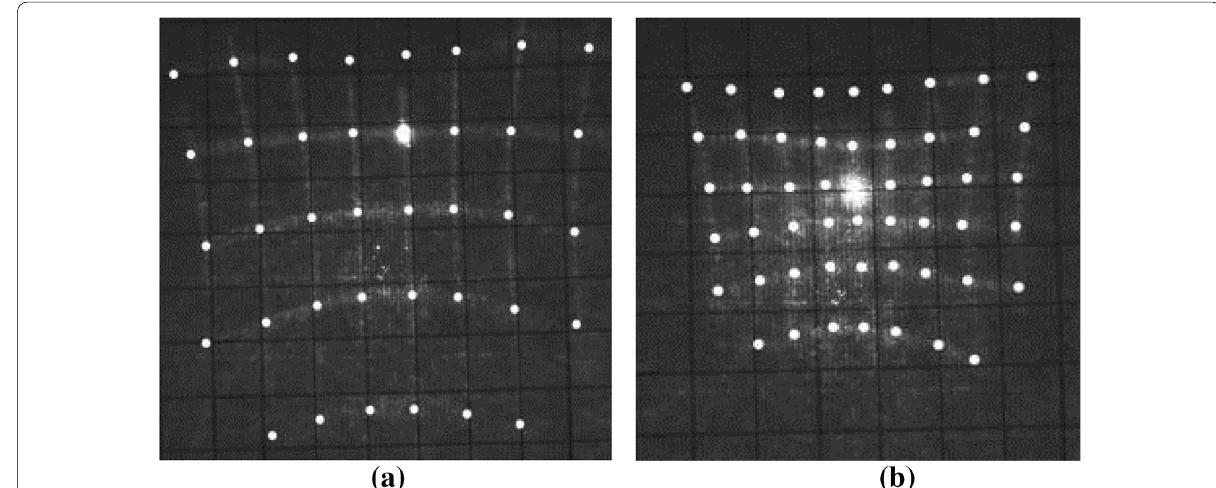
Figure 7 (0, 1) mode experimental results